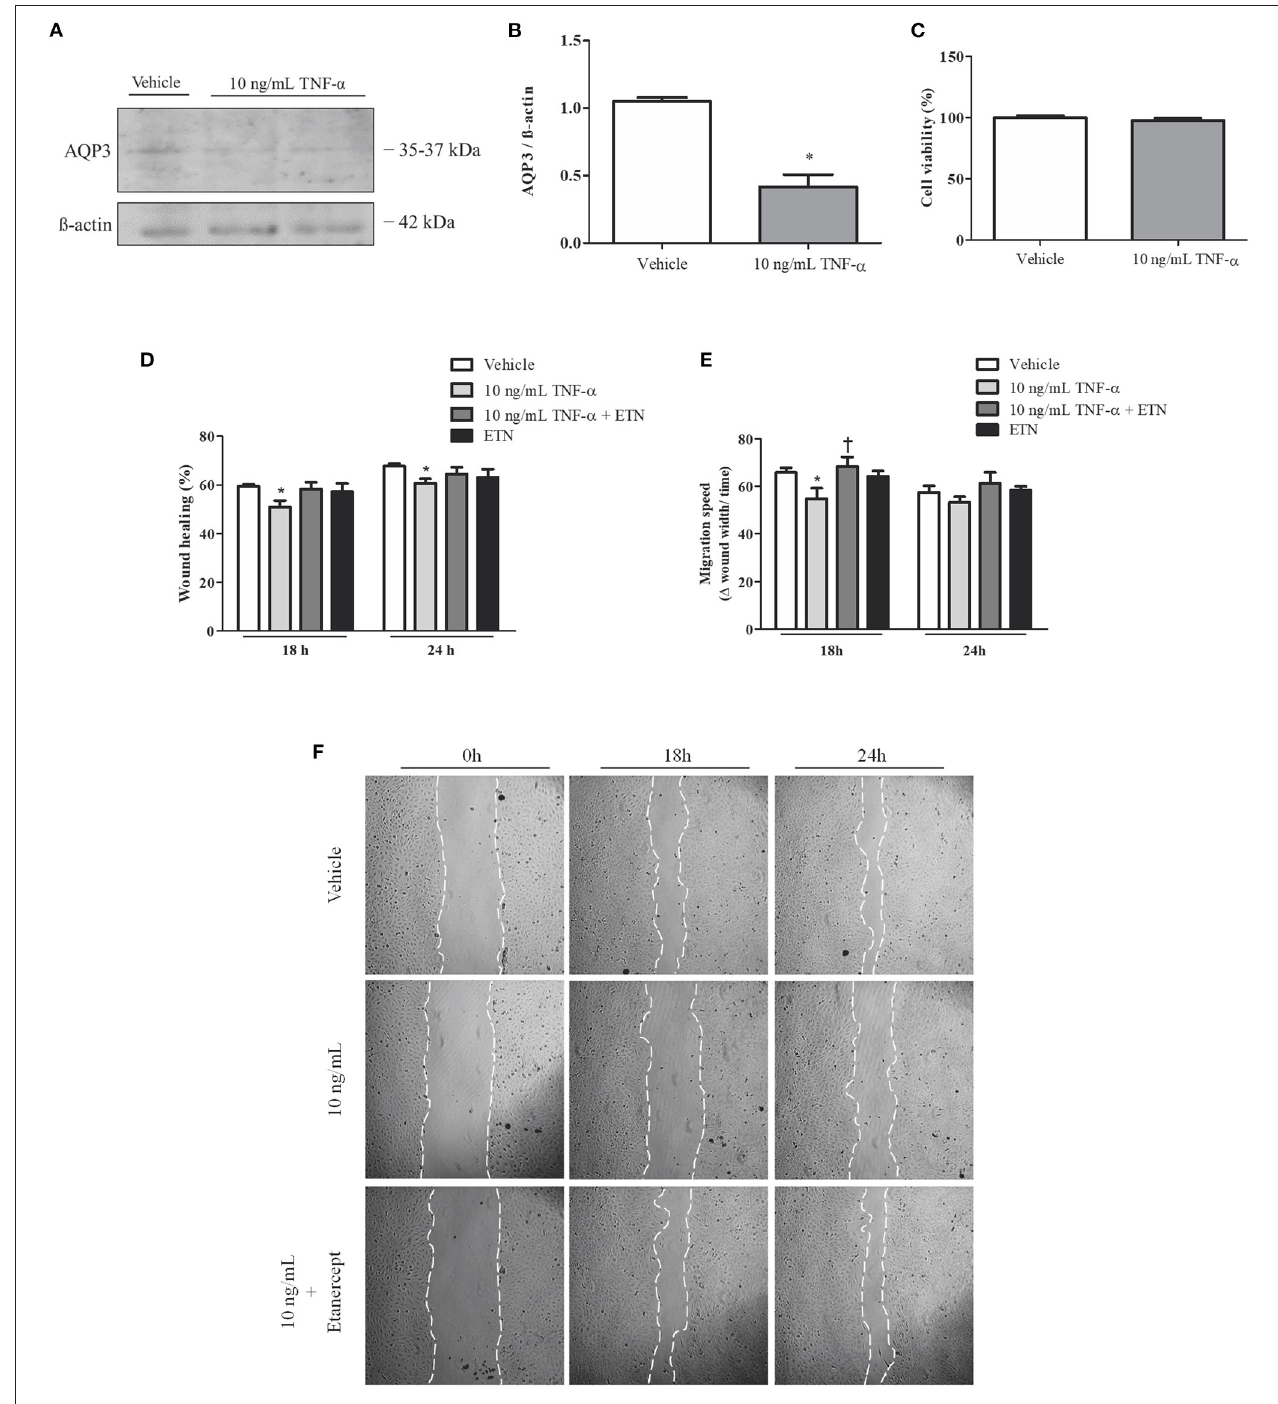
FIGURE 4 | Tumor necrosis factor-alpha (TNF- α ) reduces aquaporin 3 (AQP3) expression and impairs human trophoblastic cell migration. Concomitantly, simultaneous incubation with TNF- α and etanercept (ETN) ameliorates cell migration speed. (A) Representative picture of Western blot membrane with the respective AQP3 molecular weight. (B) Bar graph showing AQP3 expression in Swan 71 cells incubated with vehicle ( n = 5) or 10ng/ml TNF- α ( n = 6). (C) Bar graph showing cellular viability ( n = 5). (D) Bar graph showing the wound healing percentage in Swan 71 cells treated with vehicle ( n = 6), 10ng/ml TNF- α ( n = 7), TNF- α + etanercept ( n = 3), or 1 µ g/ml etanercept ( n = 2) after 18 and 24h. (E) Bar graph showing the migration speed in Swan 71 cells treated with vehicle, 10ng/ml TNF- α , TNF- α + etanercept, or 1 µ g/ml etanercept after 18 and 24h; n = 4. (F) Representative pictures of wound healing assay of Swan 71 cells incubated with or without 10ng/ml TNF- α and 1 µ g/ml etanercept after 0, 18, and 24h. Values are presented as means ± SEM, and data were analyzed by two-way ANOVA, followed by Bonferroni posttest. * p < 0.05 vs. vehicle; † p < 0.05 vs. 18h 10ng/ml TNF- α incubation.